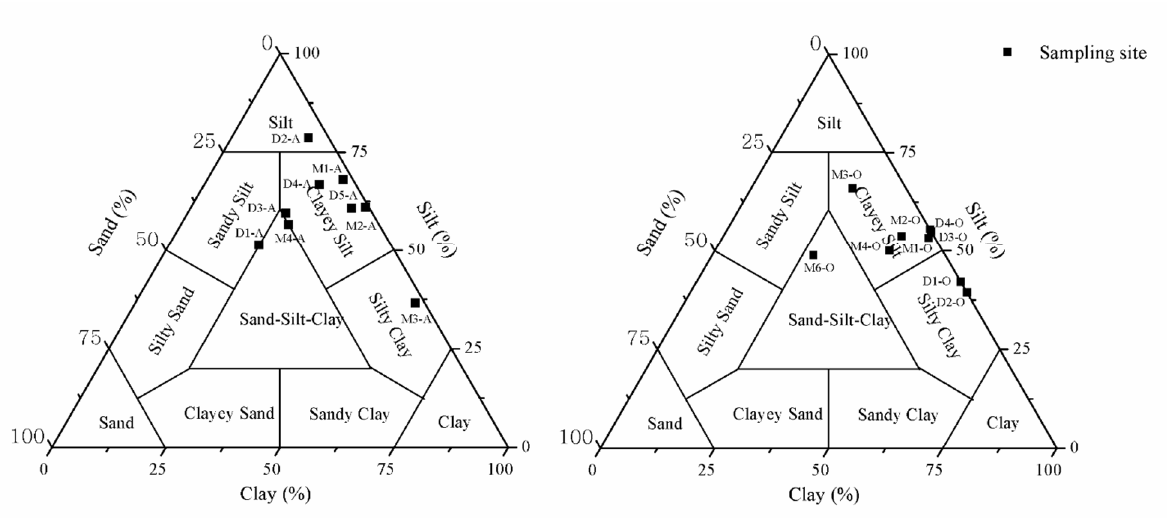
Figure 2. Shepard triangle classification diagram of surface sediment sampling sites in Manwan (M) and Dachaoshan (D) cascading dams. and Dachaoshan (D) cascading